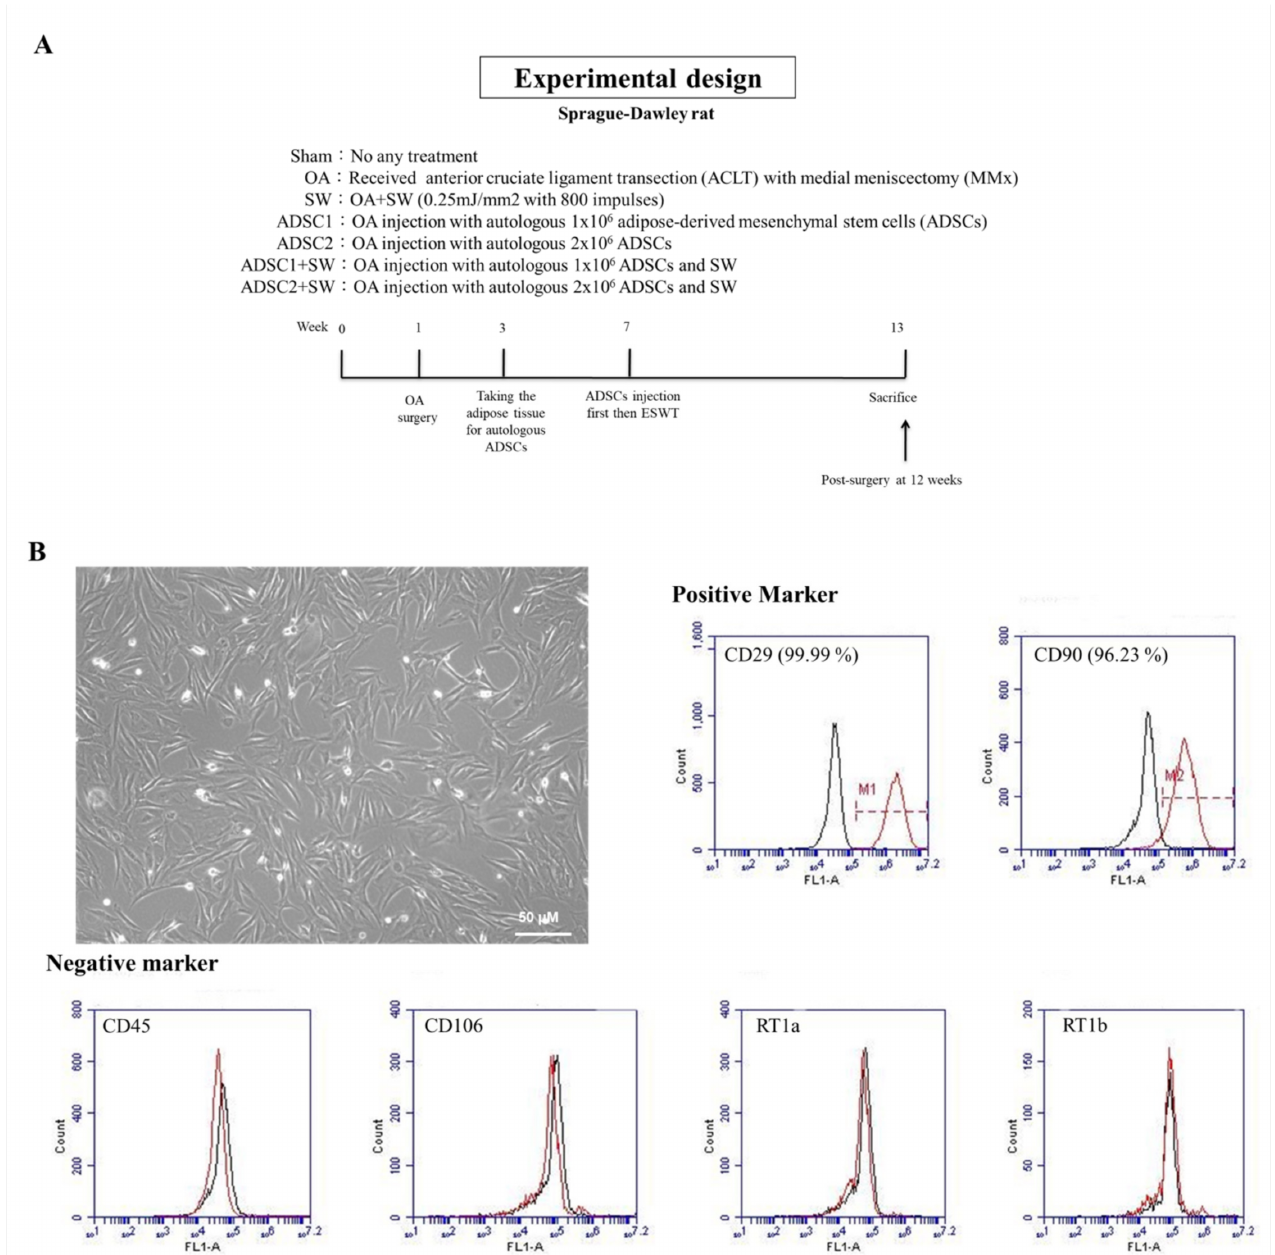
Figure 1. The study design and identification of autologous adipose-derived mesenchymal stem cells (ADSCs). ( A ) Seven groups were included: Sham, osteoarthritis (OA), shockwave therapy (SW), OA injection with autologous 1 × 10 6 ADSCs (ADSC1), OA injection with autologous 2 × 10 6 ADSCs (ADSC2), OA injection with 1 × 10 6 ADSCs and SW (ADSC1 + SW), and OA injection with 2 × 10 6 ADSCs and SW (ADSC2 + SW). The animals were sacrificed post-surgery at 12 weeks. ( B ) Morphology of cultured autologous ADSCs. White bar = 50 µ m. The cell surface makers of autologous ADSCs were analyzed. Positive markers were CD29 (99.99%) and CD 90 (96.23%); negative markers were CD45, CD106, RT1a, and RT1b. The expression percentages of marker were calculated (red line) and isotype controls were shown (black